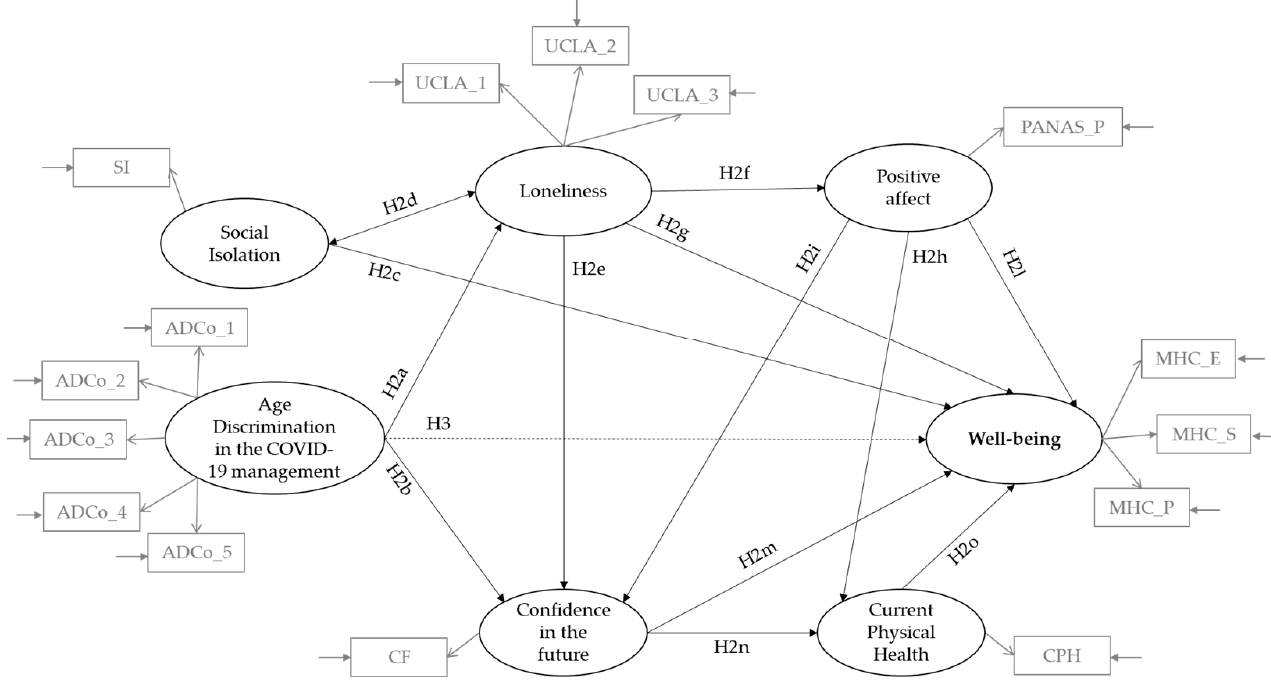
Figure 1. Conceptual Model .